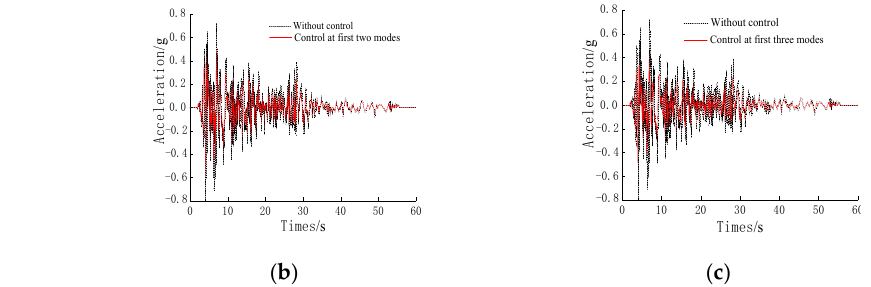
Figure 18. Time history of acceleration by optimized control at different modes under the El-Centro seismic record. ( a ) First mode. ( b ) First two modes. ( c ) First three modes.